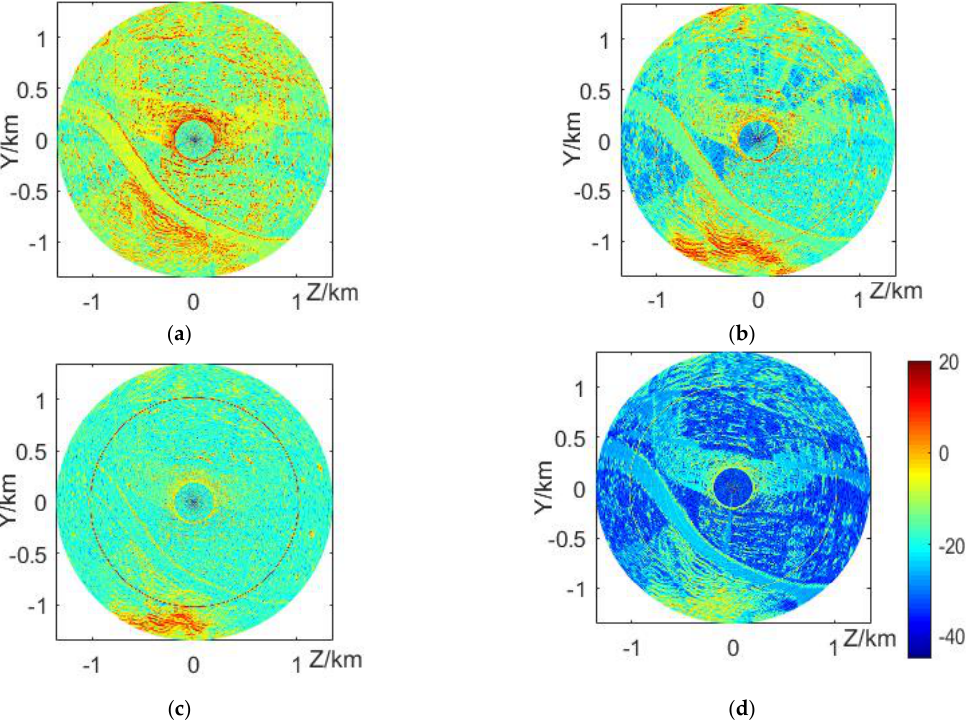
Figure 5. The clutter maps with at different radar altitudes in ( a – d ) of 500 m, 550 m, 600 m, and 650 m, respectively. These results correspond to the DEM, in which the mountainous area at the lower side of the map corresponds to the red strong clutter area at the lower part of the clutter map, the flat terrain and river area on the left form the blue weak clutter area, and there are obvious red spots in the clutter map corresponding to some high-rise buildings on the right. The “hollow” phenomenon in the central area of the clutter map is mainly due to the failure to consider the influence of the near-field effect and radar sidelobe.